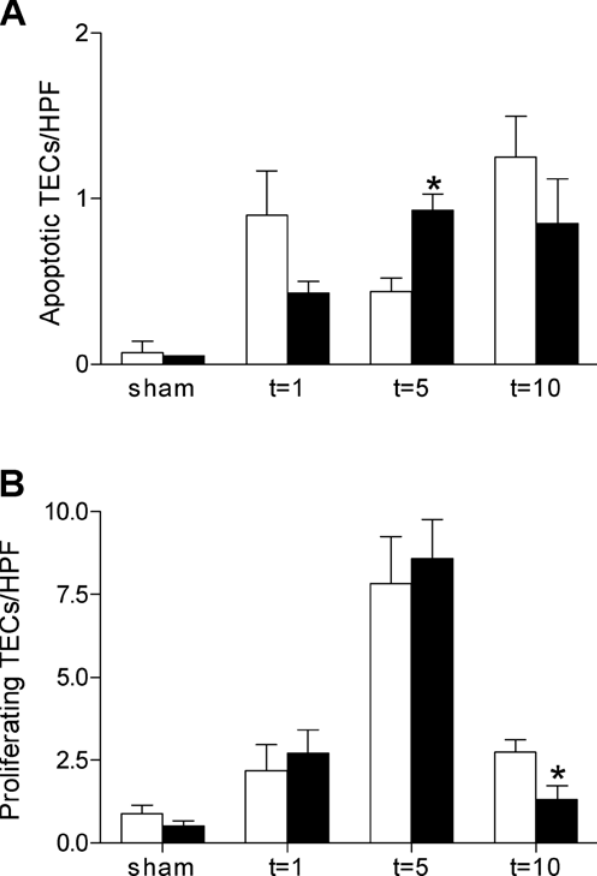
Figure 7. Apoptosis and proliferation of TECs of wild type and TLR4 2 / 2 mice. Apoptotic (A) and proliferating (B) tubular epithelial cells in kidneys from wild type (white bars) and TLR4 2 / 2 (black bars) mice at one, five and ten days after I/R injury or sham-operation. The amount of apoptotic tubular cells was significantly higher in the kidneys of TLR4 2 / 2 mice than in wild type mice five days after I/R injury, whereas ten days after I/R injury the amount of proliferating tubular cells was significantly lower in the kidneys of TLR4 2 / 2 than in kidneys of wild type mice as counted in 10 randomly selected non-overlapping high-power fields on outer medulla (magnification 6 400). Positive tubular epithelial cells from 8 mice per group were counted on renal tissue sections stained for active caspase-3 (apoptosis) and BrdU (proliferation). Data are presented as mean 6 SEM. * p , 0.05.